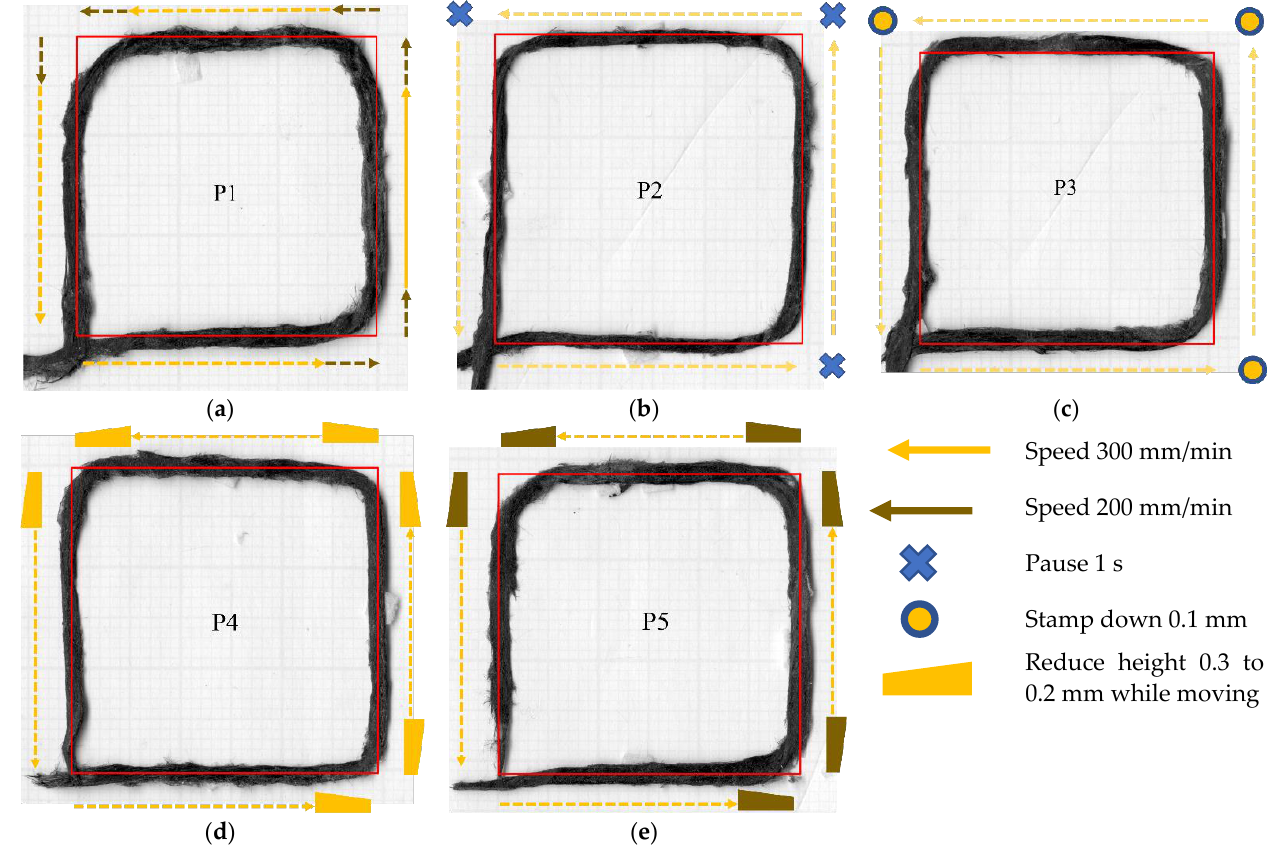
Figure 5. Additional machine actions to increase the printing accuracy following the P1 to P5